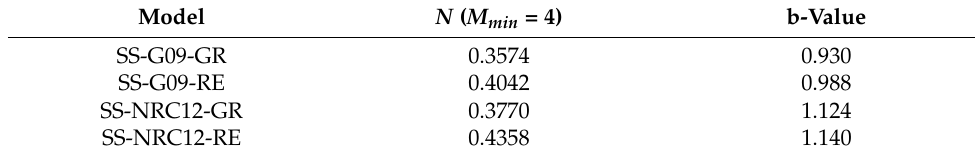
Table 5. Source characteristics for seismic source models based on the earthquake catalogue.